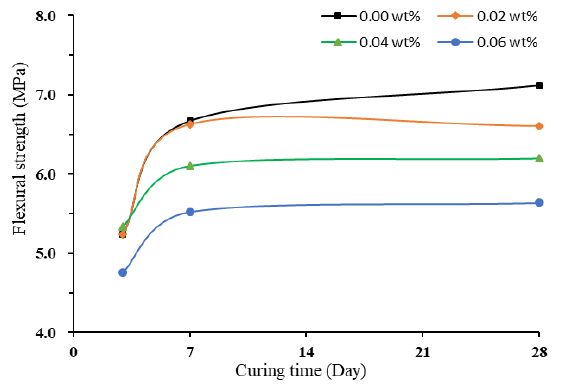
Figure 8. Flexural strength of non-TX10-added mortar prisms.